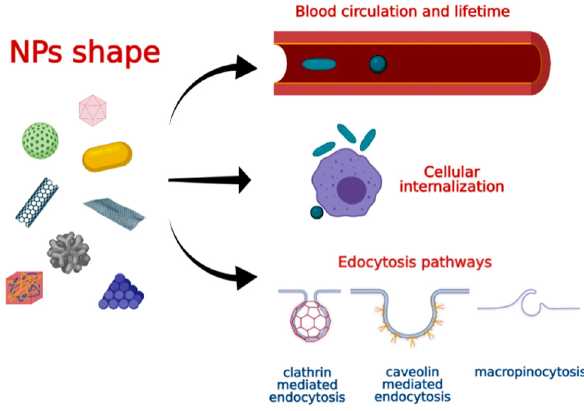
Figure 3: Factors a ff ected by nanoparticles shape: blood circulation and lifetime; cellular internalization ( depending on the NPs AR and the contact angle ) ; and endocytosis pathways ( clathrin - mediated endocytosis, caveolin - mediated endocytosis, and micropinocytosis )